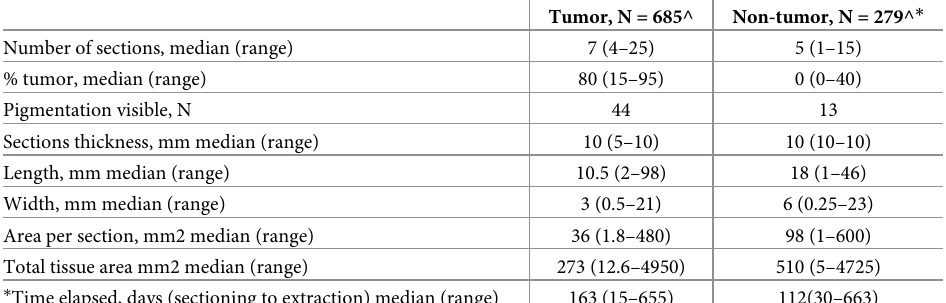
DNA this difference did not reach statistical significance (4.6 vs 3.9 ng/mm2 dsDNA, p = 0.06). No associations were observed between the quantity of co-extracted DNA/RNA and tumor Breslow thickness, tumor purity (% tumor cells), or time elapsed between tissue block sectioning to co-extraction. Time elapsed, however, had an inverse statistically significant asso- ciation with amplicon size on QC-PCR (Fig 2C). TILs were significantly associated with greater amounts of dsDNA (Fig 2D) and purity (S4A Fig in S3 Appendix). Presence of TILs was significantly associated with the ability to generate amplicons > 200bp (S4B Fig in S3 Appendix). There was a positive association between pigmentation and quantities of total RNA obtained, with heavily pigmented tumors rendering higher yields compared to both lightly pigmented and non-pigmented tumors (Fig 2E). DV200 values were also higher in RNAs extracted from pigmented lesions (Fig 2F). Ulceration was significantly associated with greater DNA A260/A280 (Fig 2G) and RNA A260/A280 values (p < 0.045, not shown). DNA and RNA samples obtained from heavily pigmented tumors had lower A260/A280 ratios Table 2. Assessment of target FFPE tissue areas for extractions of nucleic acids from tumor and non-tumor specimens. Tumor, N = 685^ Non-tumor, N = 279^ * Number of sections, median (range) % tumor, median (range) Pigmentation visible, N Sections thickness, mm median (range) Length, mm median (range) Width, mm median